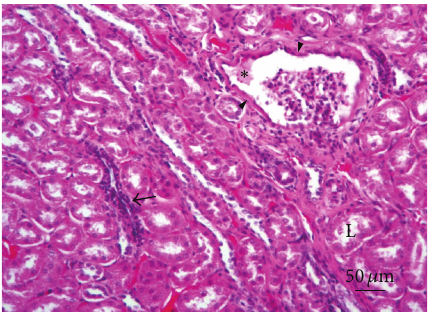
Figure 5: Kidney. Lesion Grade I. Mild interstitial mononuclear cells infiltration (arrow). Thickening of Bowman’s capsule (arrow- heads). Evidence of protein in Bowman’s space ( ∗ ). Degenerative changes of renal tubules (L). Hematoxylin and eosin.